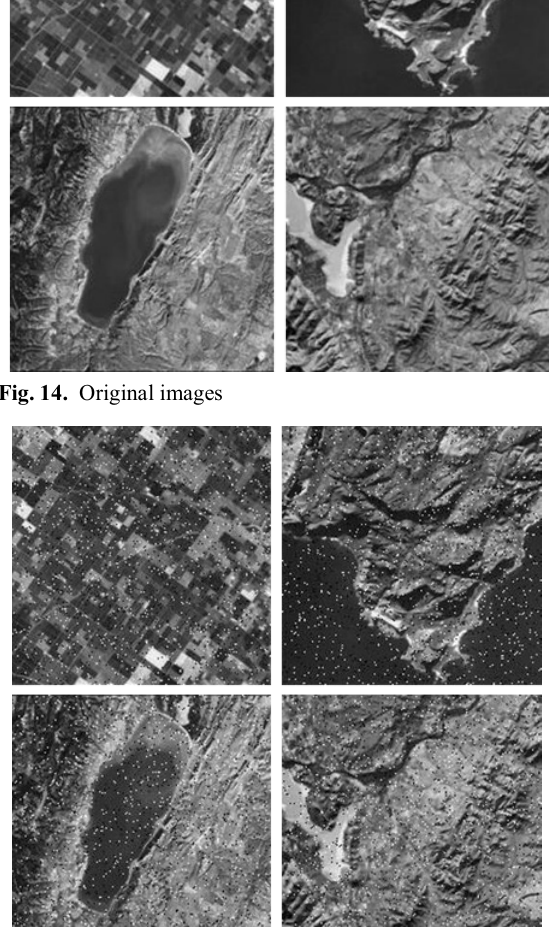
Fig. 15. Noisy images